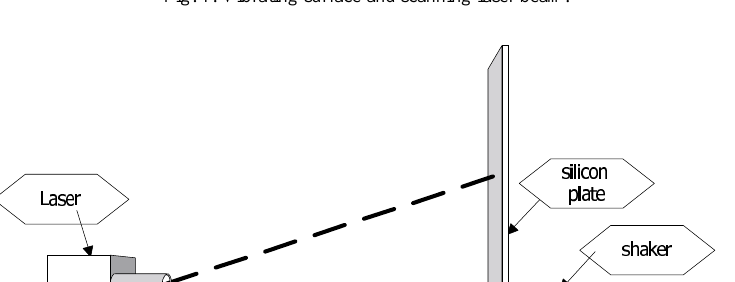
Fig. 1. Vibrating surface and scanning laser beam.